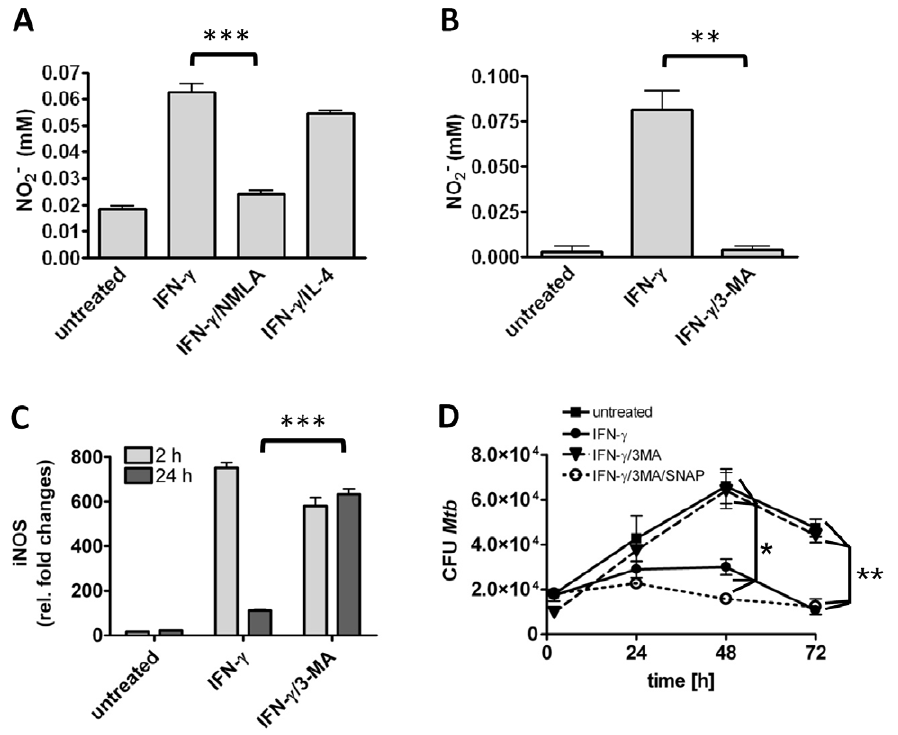
Figure 2. 3-MA inhibits NO-production in IFN- c activated BMM W . A and B) Resting or IFN- c activated (2000 U/ml O/N) BMM W were infected with M. tuberculosis (MOI 1) for 1 h, and subsequently treated with NMLA (1 mM), IL-4 (50 U/ml), or 3-MA (10 mM). Supernatants were analyzed for the production of NO using the Griess assay. Note, that 3-MA treatment abrogated NO production (B). C) NOS-2 mRNA levels were analyzed by quantitative RT-PCR 2 h and 24 h post infection with BCG (MOI 10). D) Resting or IFN- c activated (2000 U/ml O/N) BMM W were infected with M. tuberculosis (MOI 1) for 1 h and subsequently treated with 3-MA or 3-MA plus SNAP (300 m M). To determine mycobacterial survival, macrophages were lysed every 24 h and serial dilutions were plated onto agar plates for CFU determination. Data represent means 6 SD of triplicate cultures from one representative experiment out of 2 (C) or three (A, B and D), respectively. Statistical analysis was performed by ANOVA (* p , 0.05; ** p , 0.01; *** p ,